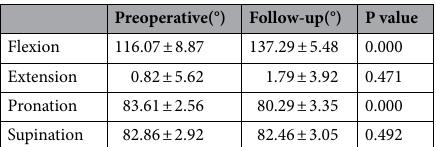
Preoperative(°) Follow-up(°) P value